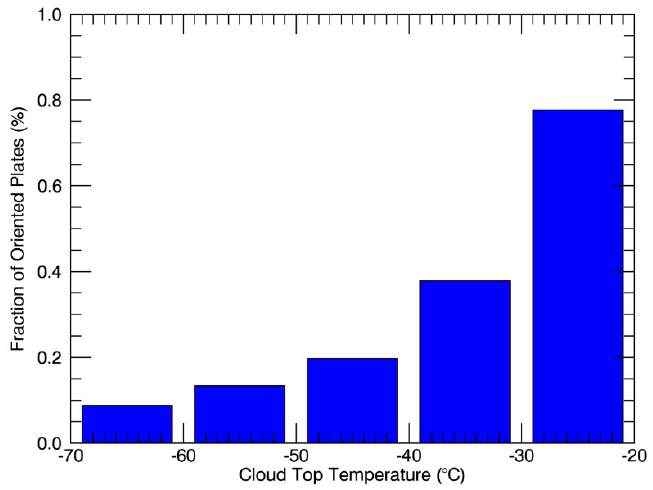
Figure 7. The fraction of oriented ice particles derived from one month (April 2007) of observations made by CALIPSO CALIOP and IIR based on the method reported by Saito et al. [100].